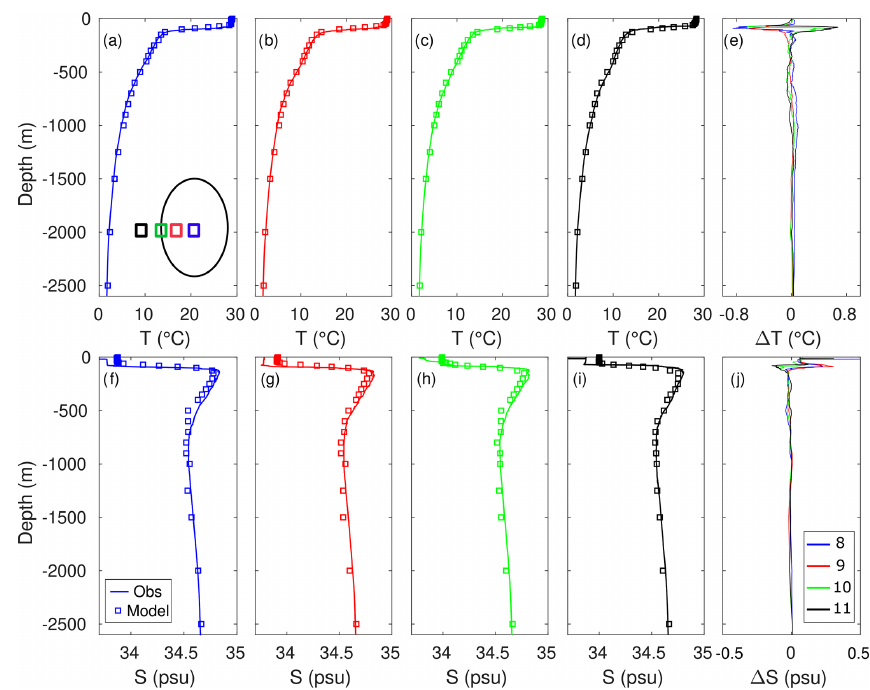
Figure 1. (a–d) Validation of reanalysis model results with in situ temperature observations at CTD stations of 08, 09, 10, and 11. (e) The bias between3 observations and reanalysis model results for temperature ( (cid:49)T ). (f–i) Validation of reanalysis model results with in situ salinity observations at the same stations. (j) The bias between observations and reanalysis model results for salinity ( (cid:49)S ). The observations and model results are shown as a solid line and squares at each